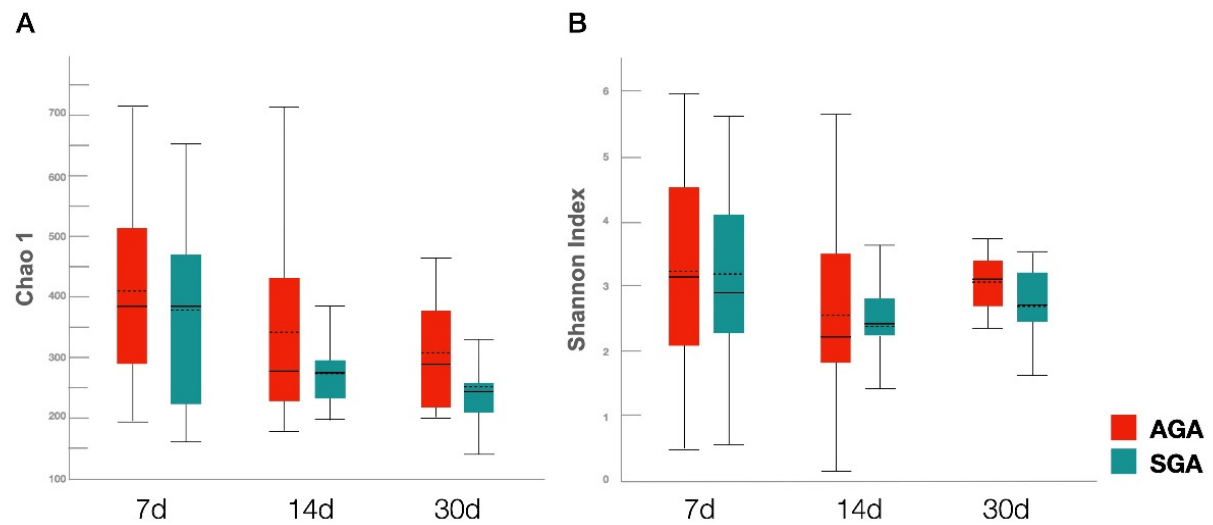
Figure 3. Comparison of gut microbial species richness and diversity in the AGA and SGA groups on days 7, 14, and 30. ( A ) Chao1 estimator. ( B ) Shannon index. Boxes, lines, and whiskers represent the interquartile range, median, and range, respectively. Abbreviations: AGA, appropriate for gestational age; SGA, small for gestational age.